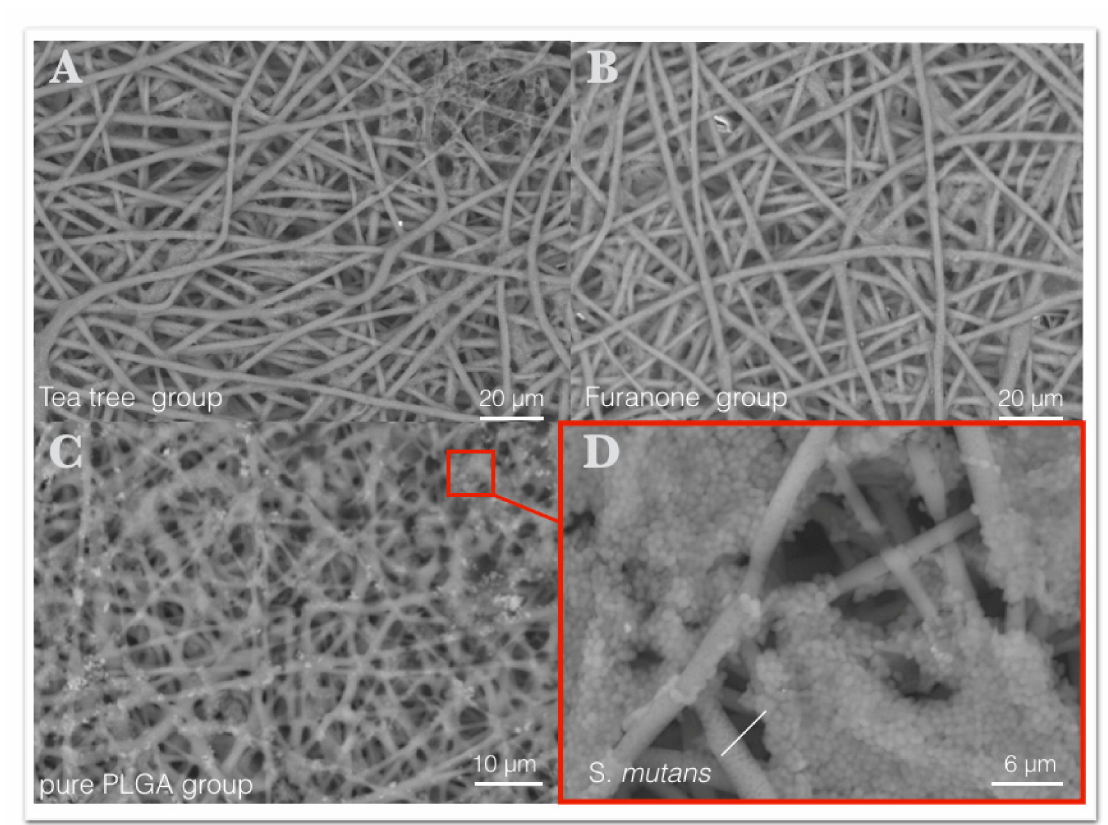
Figure 6. Scanning Electron Micrograph (SEM) of membrane surfaces after exposition to S . mutans cultures on biofilm formation assay (48 h in TSB, 37 ◦ C). ( A , B ) Antibiofilm-incorporated electrospun fibers visibly free of S . mutans colonies. ( C , D ) S . mutans colonies evidenced on electrospun fiber surfaces in the absence of the biofilm